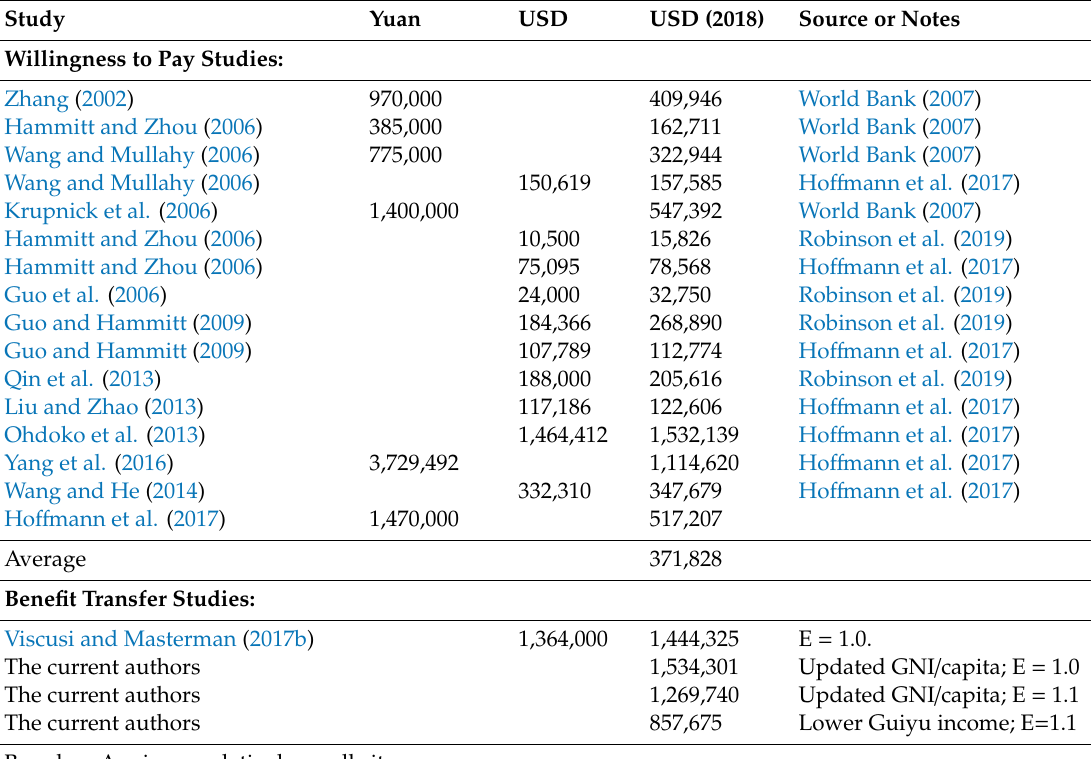
Table 4. VSL estimates for China and